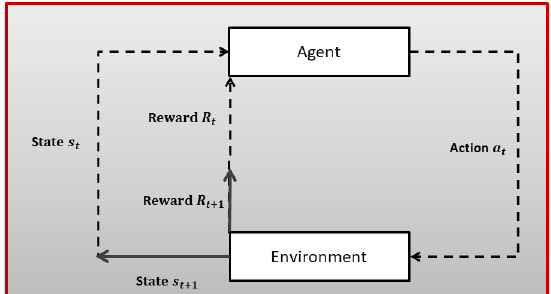
Figure 1. The Reinforcement Learning